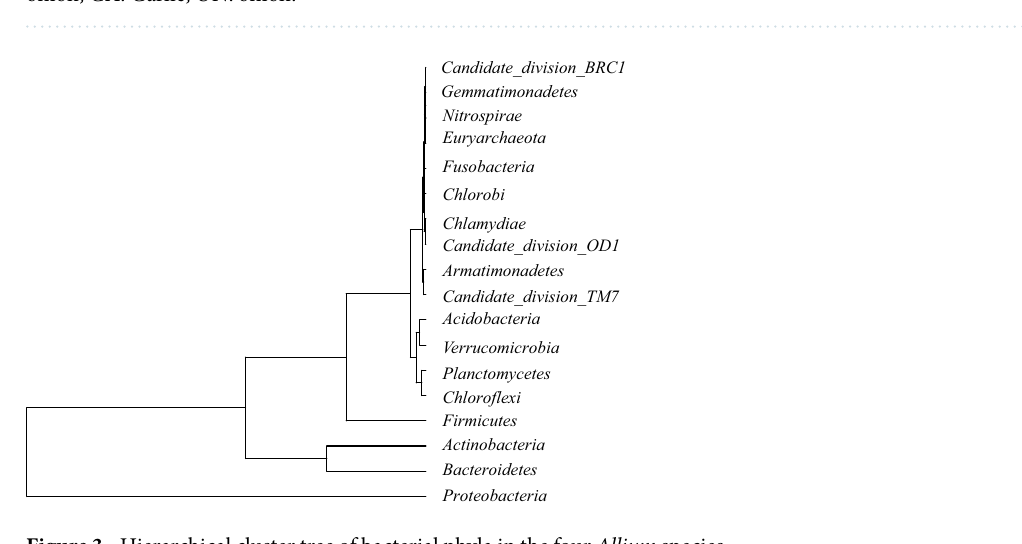
Figure 2. The relative abundance of bacterial phyla in the four Allium species. CL: Chinese leek; WO: Welsh onion; GA: Garlic; ON: onion.